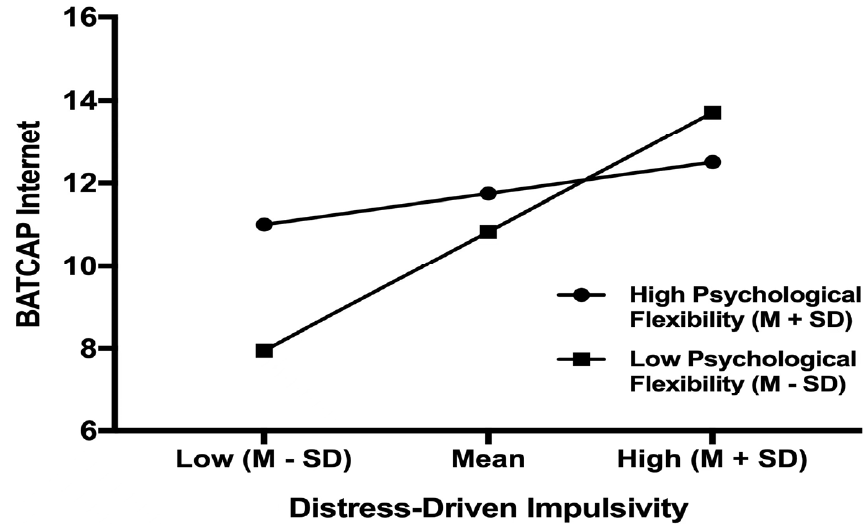
Figure 2. Simple Slope Test. Note: The moderating role of psychological flexibility in the association between DDI and PIU. The moderating effect is graphed for two levels of psychological flexibility: low flexibility/inflexible (1 SD below the mean) and high flexibility/flexible (1 SD above the mean).